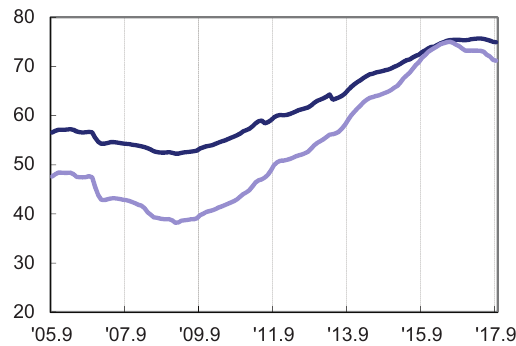
Figure 1. Changes in the rent-to-price ratio between September 2005 and September 2017 Darker line denotes the nationwide trend and light one indicates the trend in Seoul (unit: %) (source: KB Kookmin Bank, Ratio of rent (Jeon- sei) to purchase price for